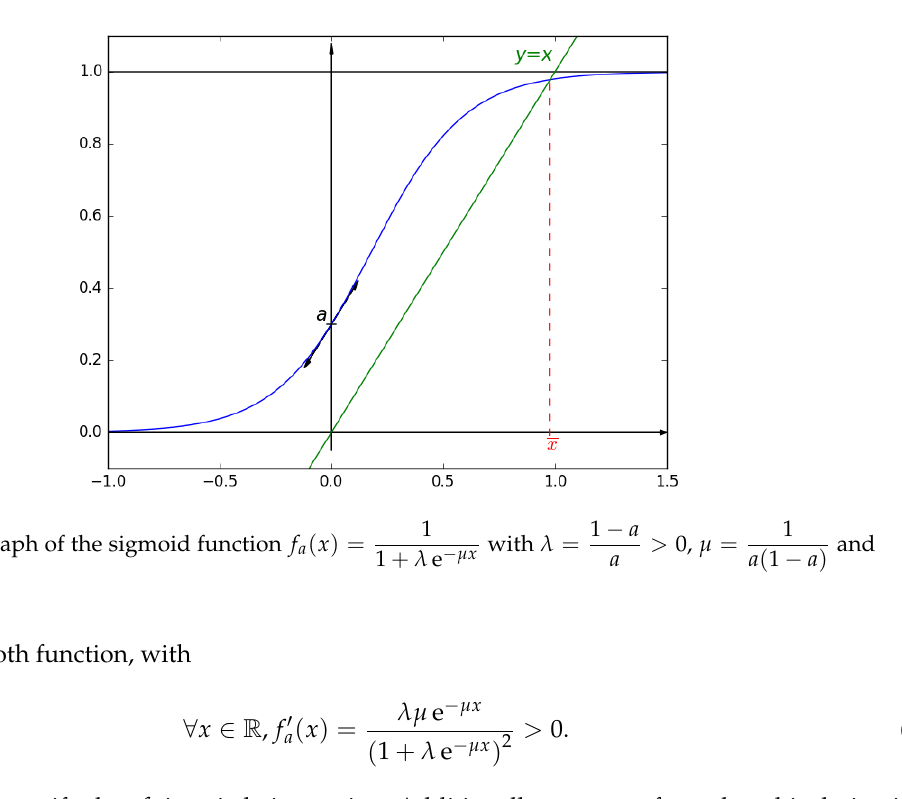
1 with λ = 1 + λ e − µ x